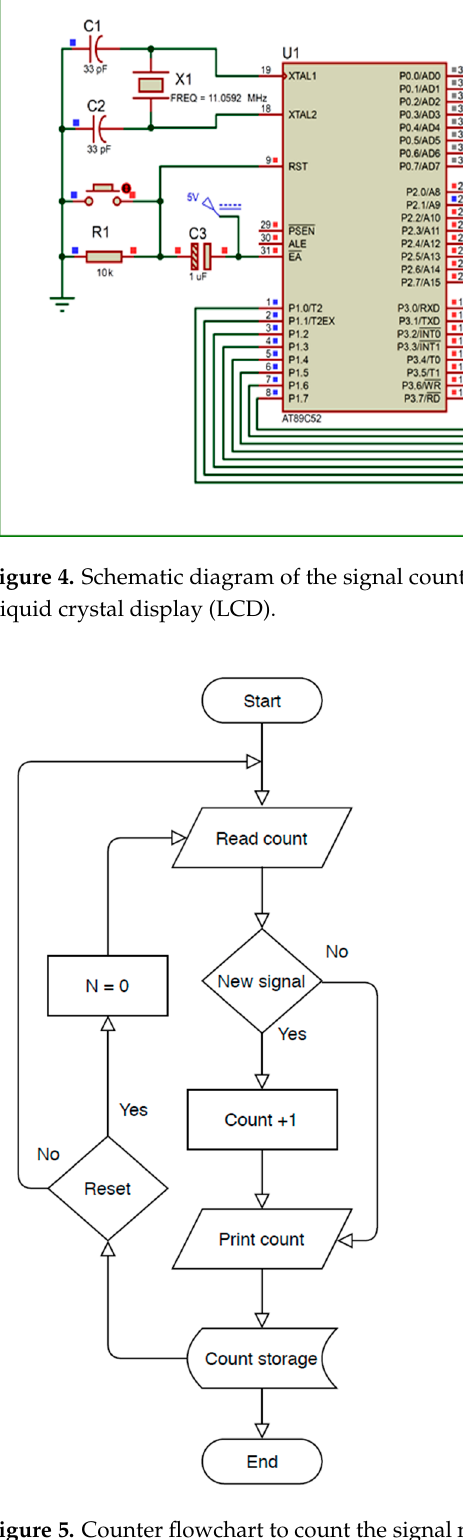
Figure 5. Counter flowchart to count the signal numbers.